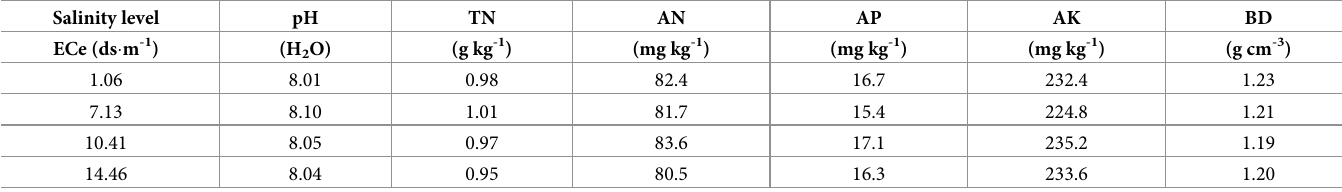
Table 1. Environmental parameters of soil from four field testing areas. TN: total nitrogen; AN: available nitrogen; AP: available phosphorus; AK: available potassium; BD: bulk density; ECe: electrical conductivity. Data were measured using surface soil (0 to 20 cm) in early spring before transplanting seedlings in 2015. Salinity